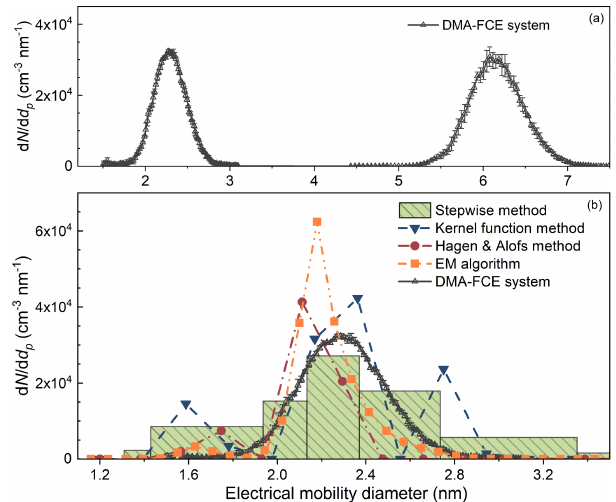
Figure 8. The experimental testing results of the four inversion methods when the PSM was measuring sub-3nm particles with the influence of larger particles. The particle number concentrations for the inversion and the particle size distribution detected using the DMA–FCE system were the sums of two separate experiments rather than real data obtained in a single experiment.